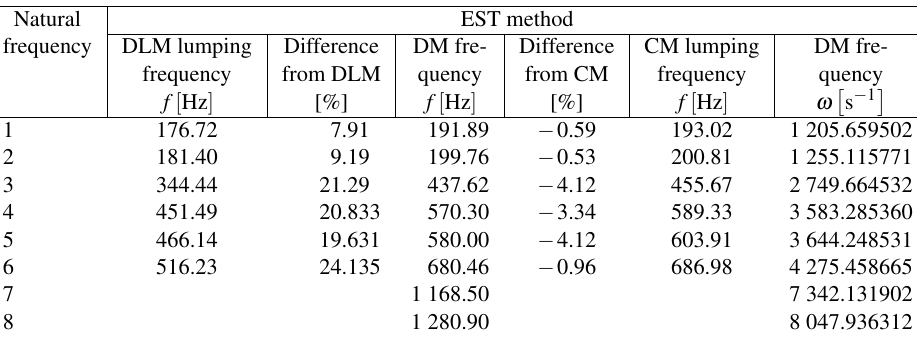
Fig. 12. Sparsity pattern of the matrix spA of a seven-bar truss. Table 2. Natural frequencies of the seven-bar